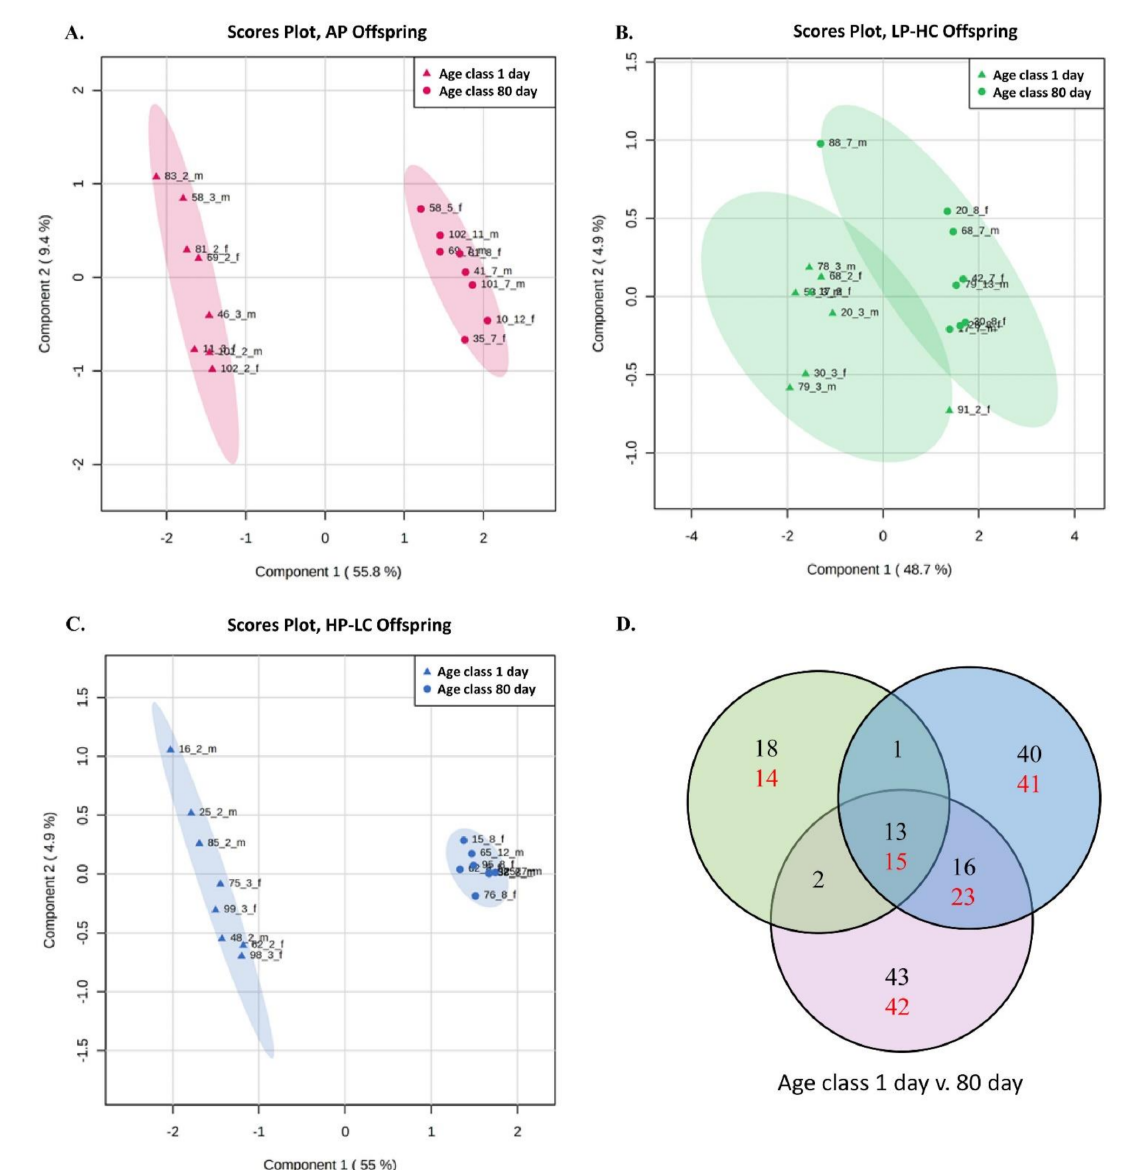
Figure 3. Partial least square discriminate analysis (PLS-DA) and significantly different metabolites between age class 1 and 80 day porcine offspring exposed to low (LP-HC; 1:10.4), high (HP-LC; 1:1.3) or adequate (AP; 1:5) protein to carbohydrate ratio diets during gestation. PLS-DA plot for ( A ) AP (Measure, 3 comps; Accuracy, 1; R 2 = 0.97; Q 2 = 0.98), ( B ) LP-HC (Measure, 1 comp; Accuracy, 0.875; R 2 = 0.59; Q 2 = 0.41), ( C ) HP-LC (Measure, 5 comps; Accuracy, 1; R 2 = 1; Q 2 = 0.97) and ( D ) the number of differently abundant metabolites between the different offspring (black, higher; red, lower, in age class 80 compared to 1 day offspring). Red, green and blue symbols and areas denote the data of offspring exposed to AP, LP-HC and HP-LC offspring,